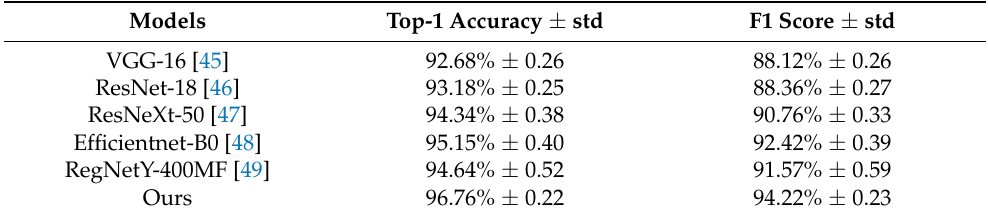
Table 3. Comparison of the classification results of our model and other models on the testing set.